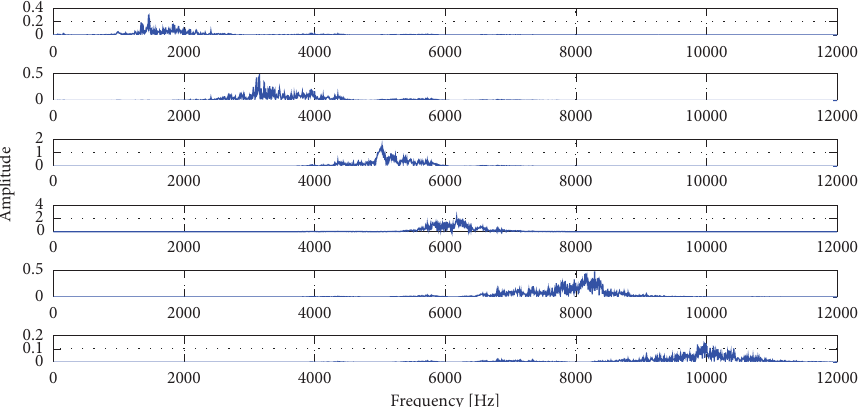
Figure 20: Spectrum of the BLIMF